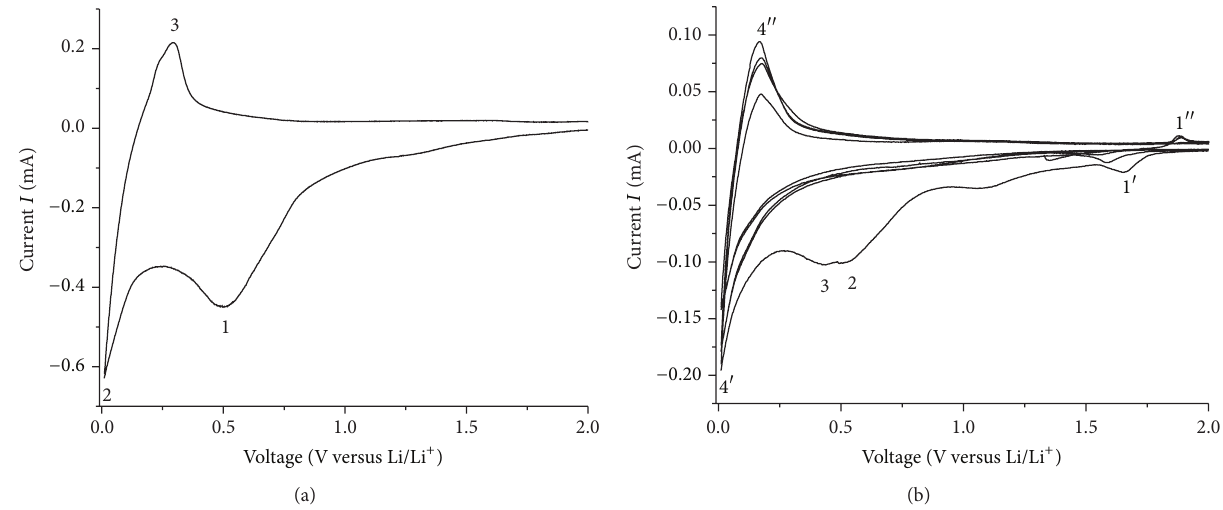
Figure 7: (a) Cyclic voltammetry of bare CNT film on copper at a scan rate of 0.10 mV/s. (b) Cyclic voltammetry of SnO 2 -CNT composite film on copper at a scan rate of 0.10